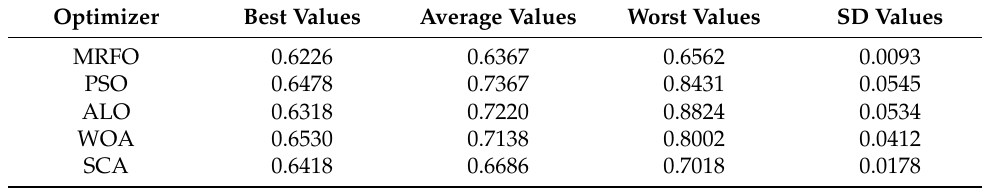
Table 9. The statistical results in the rural 51-bus system with the use of several optimizers.